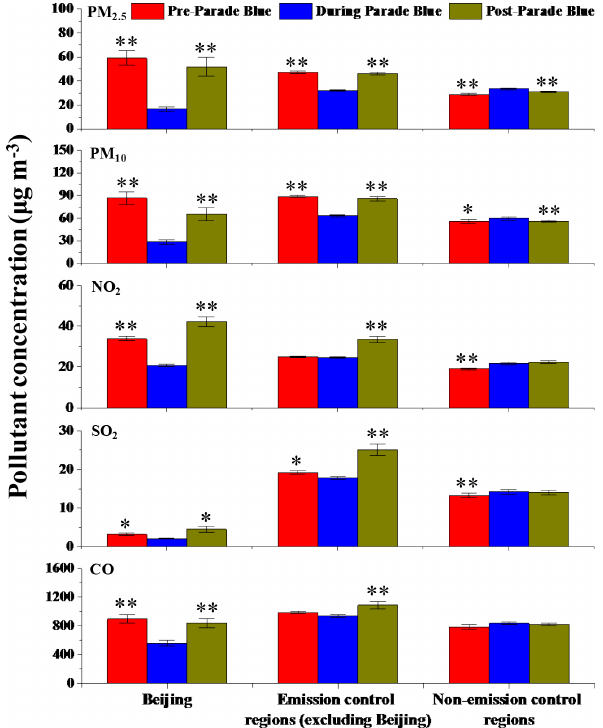
Figure 3. Comparison of PM 2 . 5 , PM 10 , NO 2 , SO 2 and CO con- centrations between non-Parade Blue periods (the pre- and post- Parade Blue periods) and Parade Blue period at Beijing, cities in emission control regions (excluding Beijing) and other cities in non- emission-control regions (one asterisk on bars denotes significant difference at p < 0.05, while two asterisks on bars denote signifi- cant difference at p <